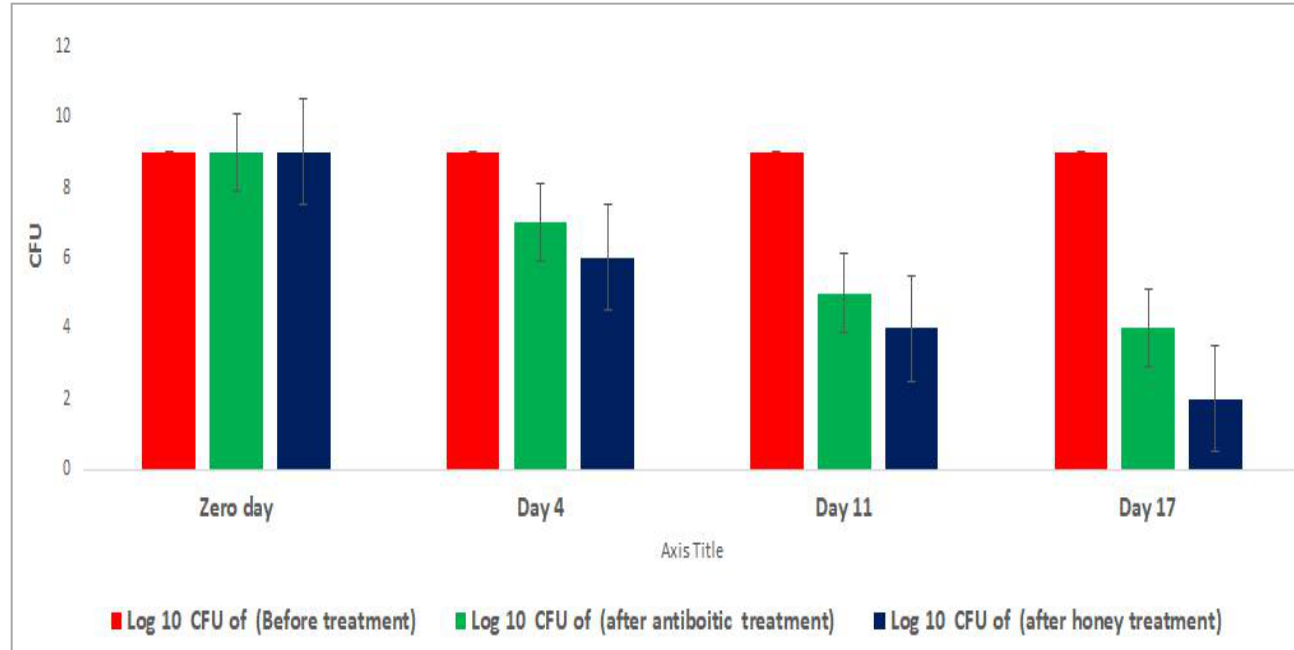
Figure 3. Total bacterial count (Log10) before and after treatment with Saudi Talh